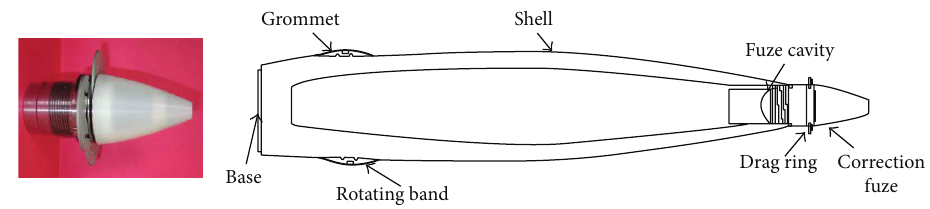
Figure 8: Drag ring brake module.